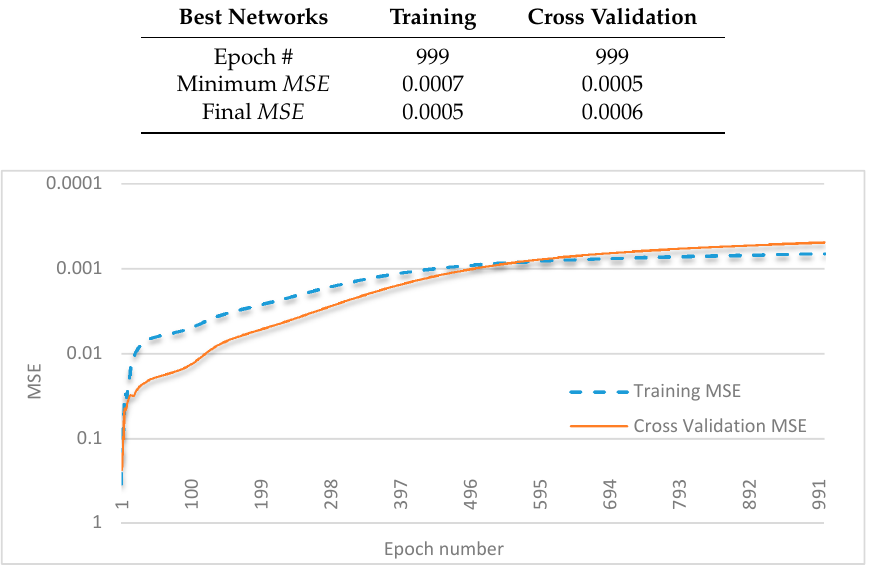
Figure 7. The mean square error ( MSE ) for the proposed SOFM model using 1000 epochs.